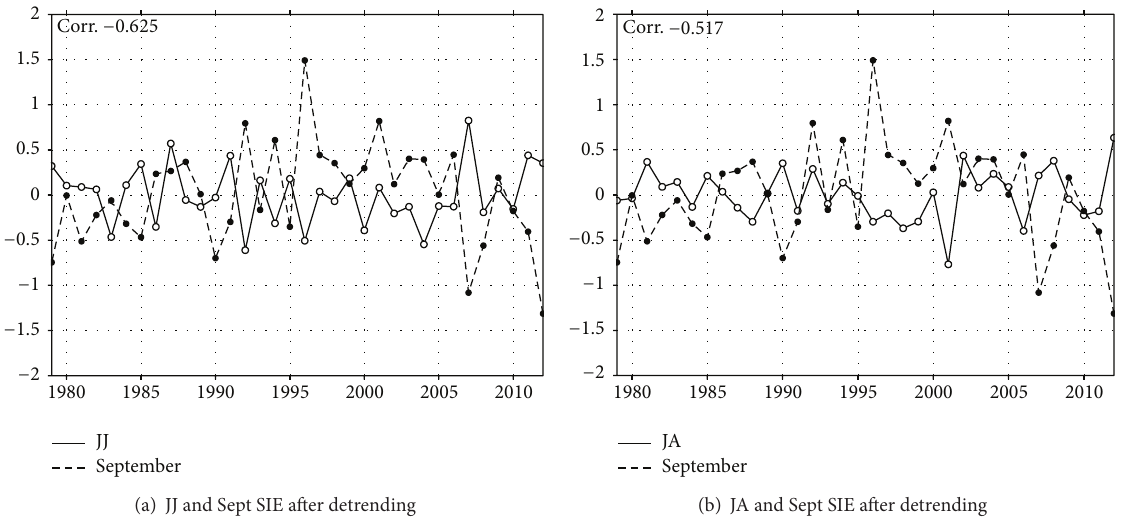
Figure 2: The time series of sea ice extent (SIE) difference for JJ and JA SIE and the September SIE in 1979–2012 after detrending: (a) JJ SIE and SIE in September and (b) JA SIE and SIE in